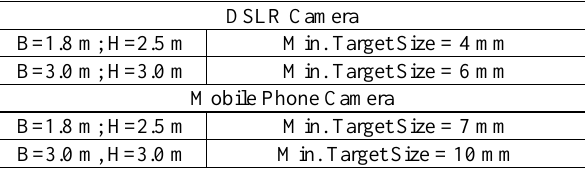
Table 4: Minimum target diameters for different configurations. Table 4 details the recommended minimum target size (centre